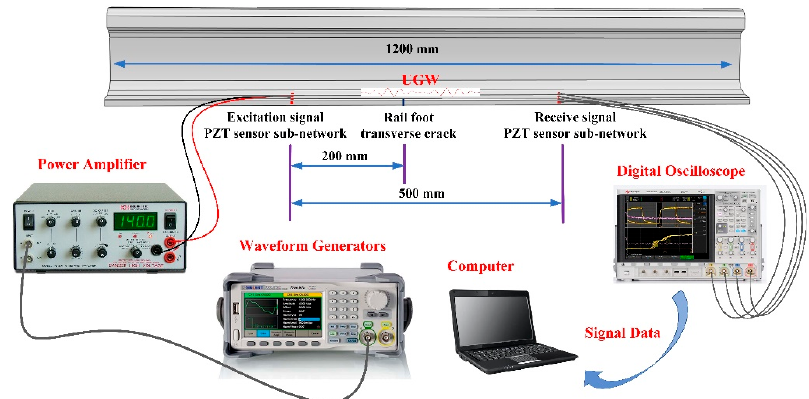
Figure 15. Schematic diagram of the experimental system.